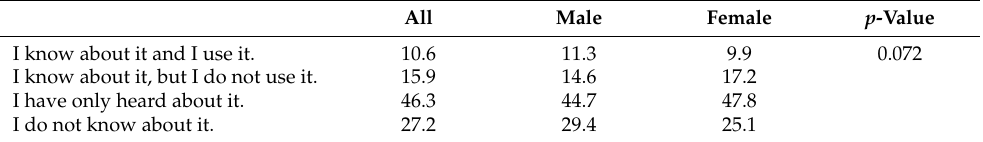
Table 12. Perception and utilization of the dietary reference intake for Japanese people. All Male Female p -Value